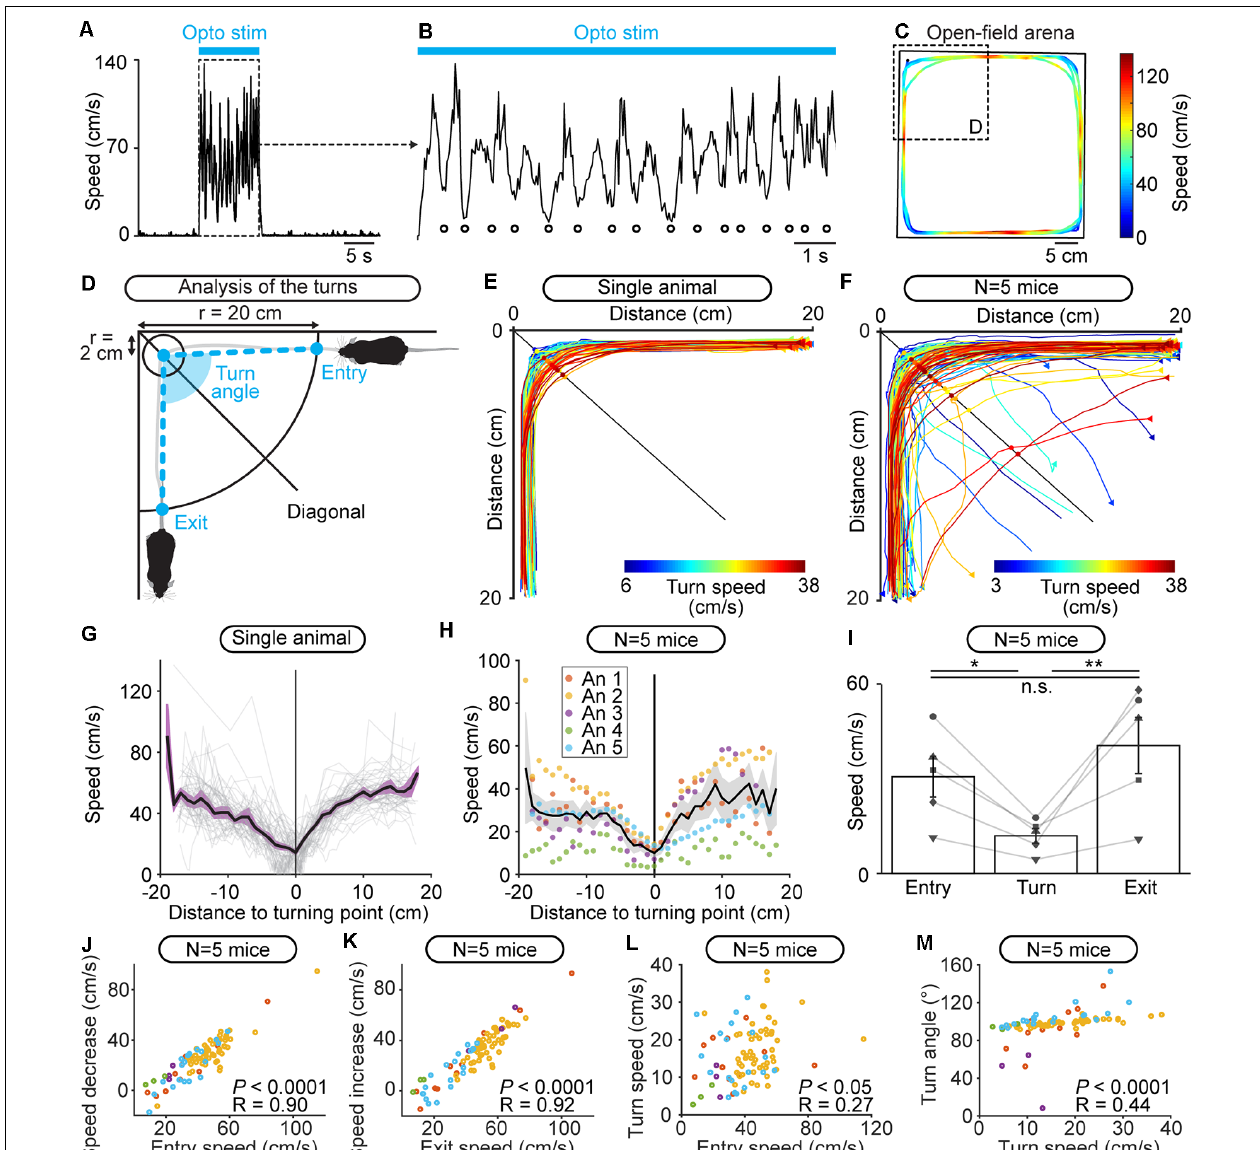
FIGURE 5 | Freely behaving mice brake and turn during locomotion evoked by optogenetic stimulation of the cuneiform nucleus (CnF) in Vglut2-ChR2-EYFP mice in the open-field arena. (A) Raw data showing that locomotor speed is modulated during optogenetic stimulation of the CnF (470 nm laser, 10 s train, 20 Hz, 10 ms pulses, 11% of laser power). (B) Magnification of (A) showing rhythmic speed decrease (white circles) during CnF stimulation (blue solid line). (C) Color plot illustrating the locations of the speed decreases during CnF stimulation in the open-field arena (same data as in A,B ). Colder colors (blue) illustrate slower speeds. (D) Animal’s speed was measured when moving in 20 cm circles centered on each corner of the arena. The speed at the entry of the corner, during the turn (in a 2 cm circle centered on the location where the animal crossed the corner’s diagonal), and at the exit of the corner was calculated (see “Materials and Methods” section). The turn angle was measured between the positions of the animal: (i) at the entry of the corner; (ii) during the turn; and (iii) when exiting the corner (see “Materials and Methods” section). (E,F) Raw data showing the extracted locomotor trajectories in the corners of the arena during optogenetic-evoked locomotion in a single animal (E, 470 nm laser, 10 s train, 20 Hz, 10 ms pulses, 11% of laser power) and in five animals ( F , 470 nm laser, 10 s train, 20 Hz, 10 ms pulses, 10–24% of laser power). Warmer colors (red) illustrate trajectories with higher speeds during the turn. Triangles illustrate movement onsets. Dots illustrate diagonal crossings. (G) Locomotor speed as a function of the distance to the corner’s diagonal during each turn (gray) shown in (E) for a single animal. In black, the averaged speed ( ± sem in purple) is shown. (H) Locomotor speed as a function of the distance to the diagonal during the turns of the five animals (An) illustrated in (F) . In black, the mean speed ( ± sem in gray) is shown. (I) Entry speed, turn speed and exit speed for five animals (10 stimulations per animal, * P < 0.05, ** P < 0.01, n.s., not significant, P > 0.05, Student-Newman-Keuls test after a one way ANOVA for repeated measures, P < 0.01). (J) Relationship between the speed at corner entry, and the difference between entry speed and turn speed in five mice (linear fit, P < 0.0001, R = 0.90, n = 87 turns pooled from 50 stimulations, 10 stimulations per animal). (K) Relationship between the speed at corner exit, and the difference between exit speed and turn speed (linear fit, P < 0.0001, R = 0.92). (L) Relationship between the speed at corner entry and the turn speed (linear fit, P < 0.05, R = 0.27). (M) Relationship between the turn speed and the turn angle (linear fit, P < 0.0001, R =